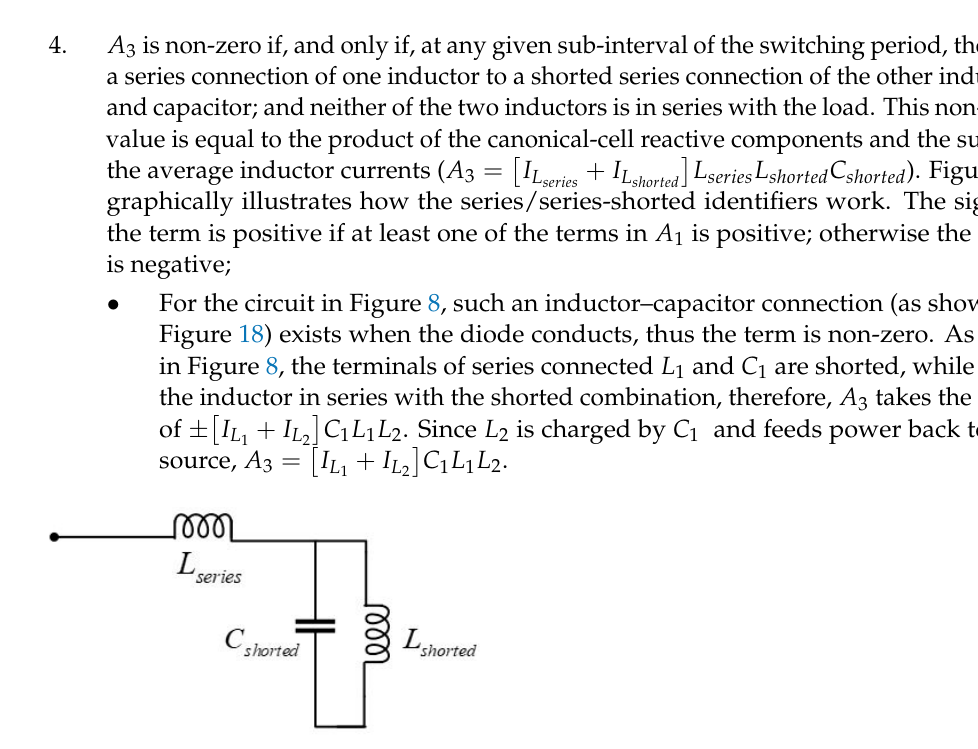
Figure 18. Pictorial representation of the rule for 𝑨 𝟑 .